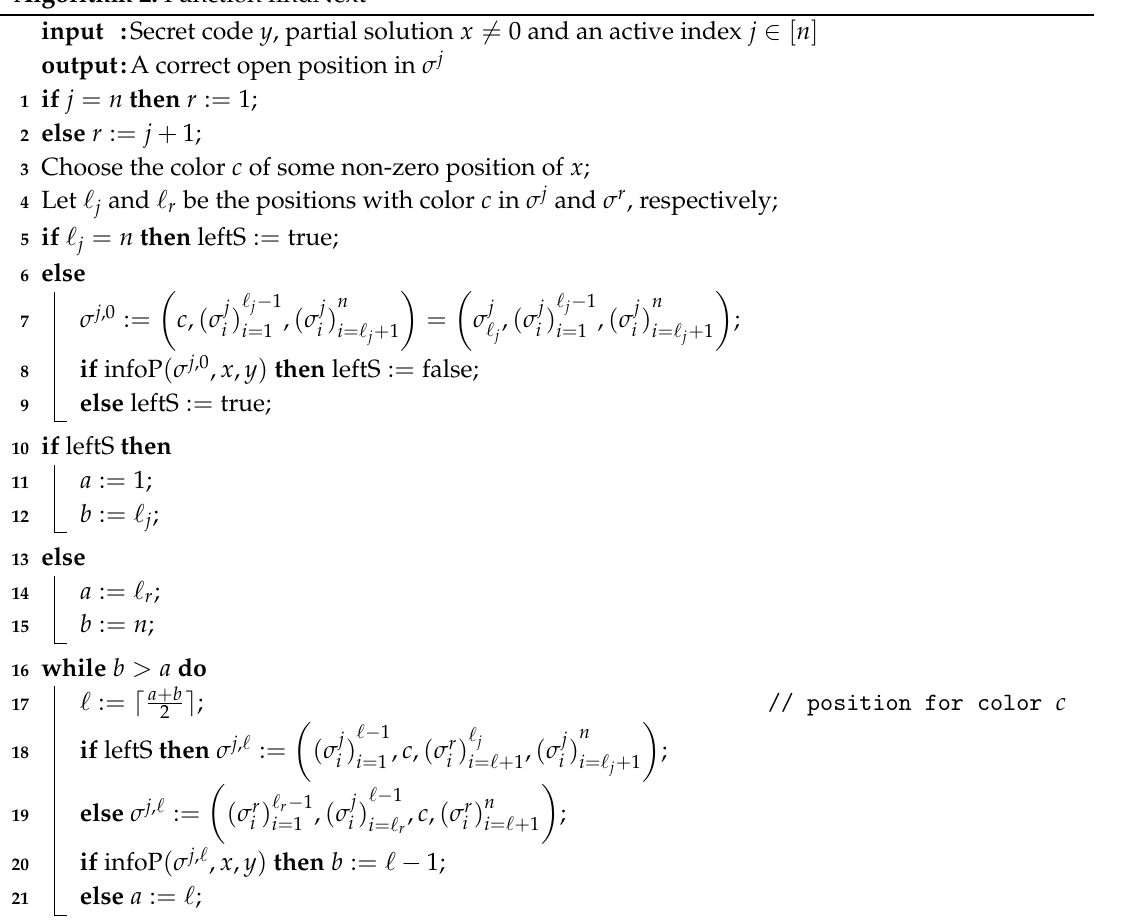
Algorithm 2: Function